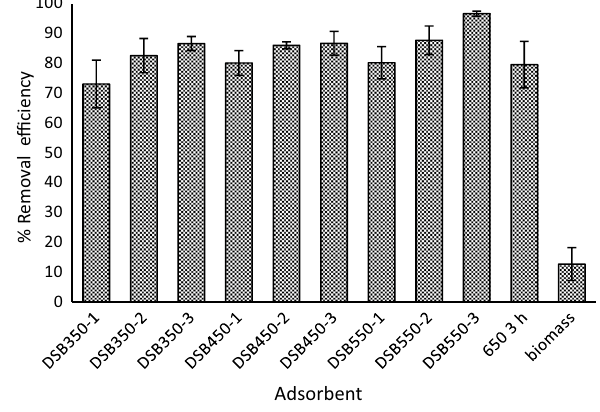
Fig. 1 Adsorption capacity of date seed-derived biochar for Pb 2+ removal (initial concentration = 0.5 mM; biochar: solu- tion ratio = 10 g L −1 ; time = 24 h; pH 6; room temperature; particle size = 0.6–1.4